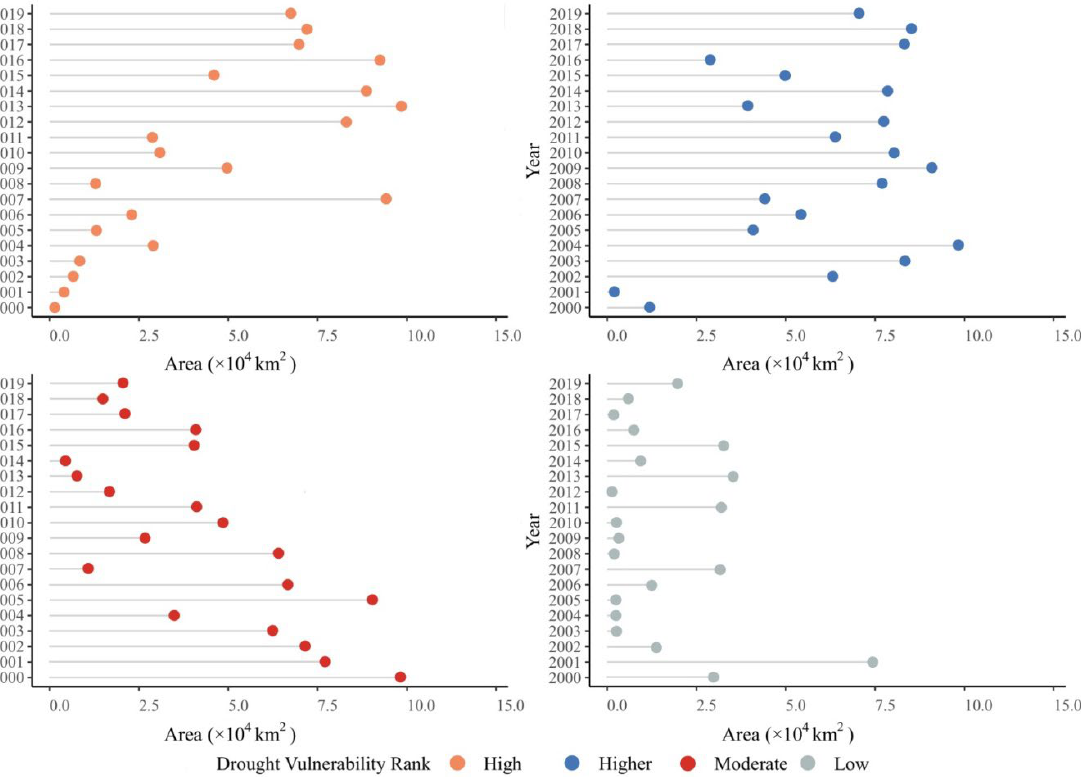
Figure 5. Trends in area variation for different drought vulnerability classes.